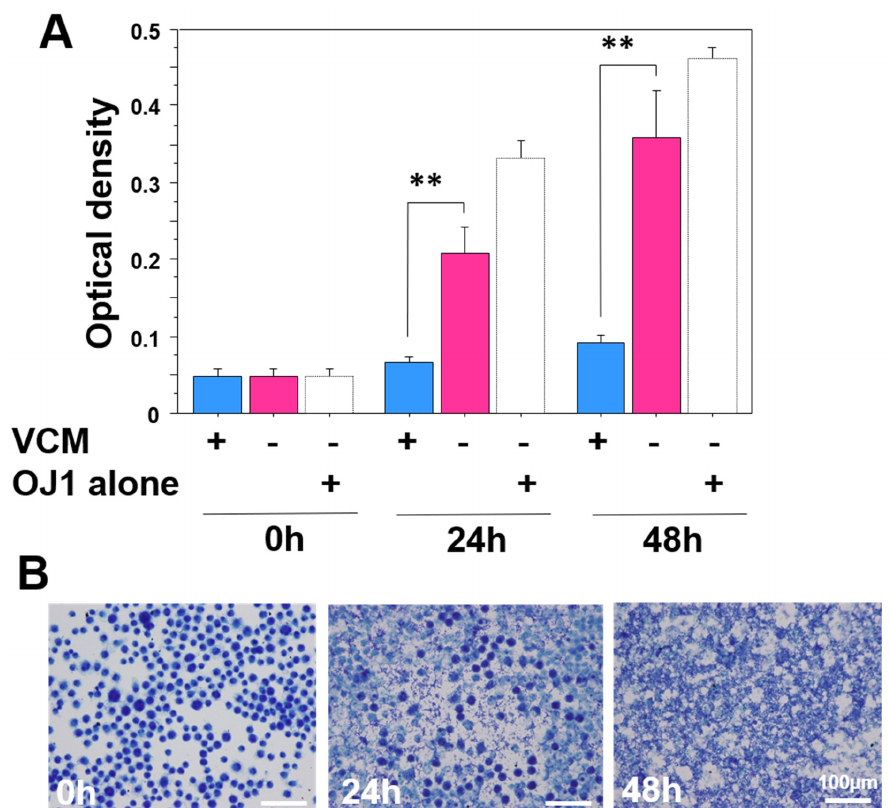
Figure 7. VCM removal from J774A cell culture with OJ-1. After the end of incubation for 10 days in the AV group, the media were changed to the VCM-excluding media. ( A ) Medial turbidity of the cultures was measured at 0, 24, and 48 h after the incubation. OJ-1 alone was used as a positive control. Data: mean ± S.D. ( N = 3); **: p < 0.01. ( B ) Morphological alterations of the cells stained with toluidine blue at 0, 24, and 48h after the incubation in the media without